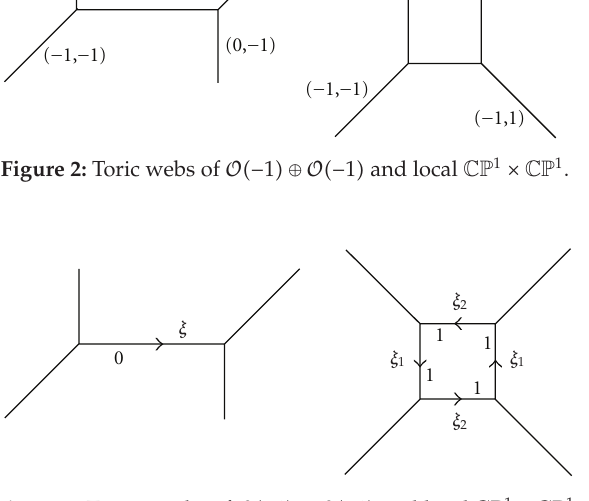
Figure 3: Toric graphs of O (cid:6) − 1 (cid:7) ⊕ O (cid:6) − 1 (cid:7) and local CP 1 × CP 1